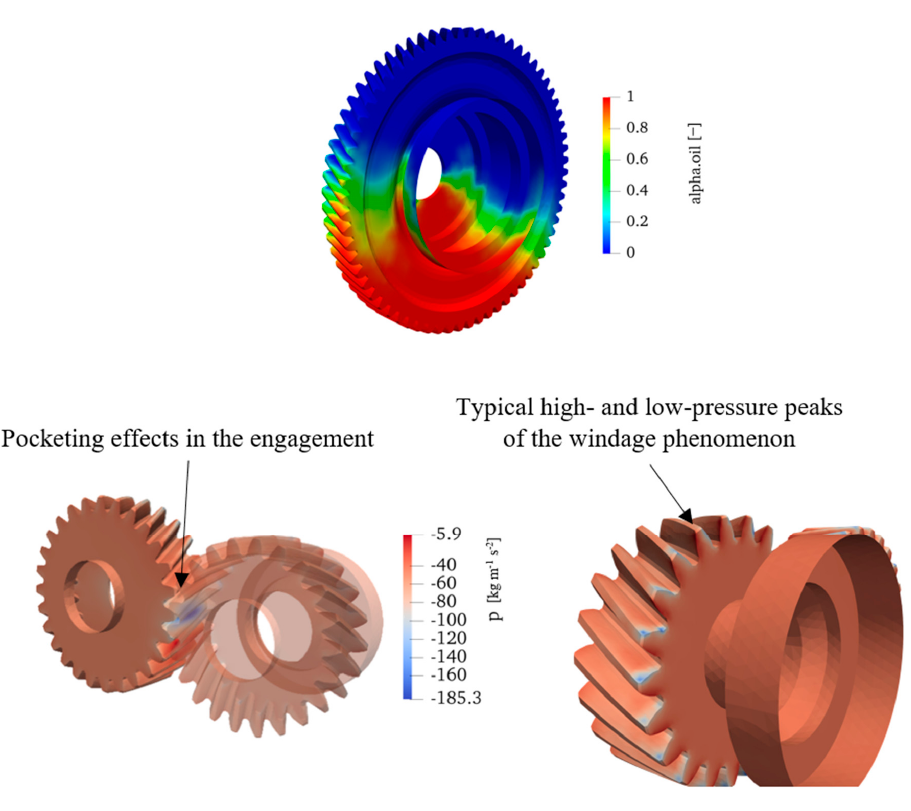
Figure 12. Wetted surface (volumetric fraction of oil–alpha oil) of the output wheel and pressure contour (p) of the input gear